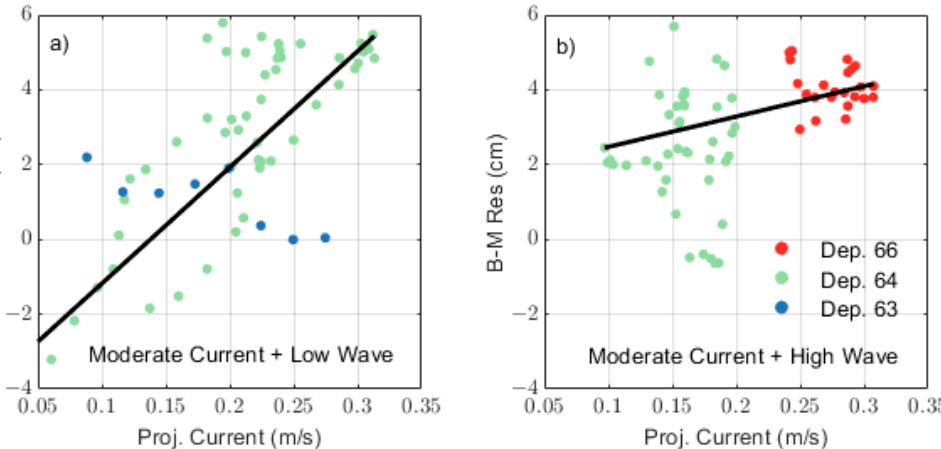
Figure 9. Line of best linear fit between moderate current and B–M residual. Solid black line is a fitted linear model. Panel ( a ) shows time window of low wave condition, while Panel ( b ) shows high wave condition. Colouring is consistent across two panels as indicated by the legend. Note Panel ( b ) does not have data from deployment 63 in it.